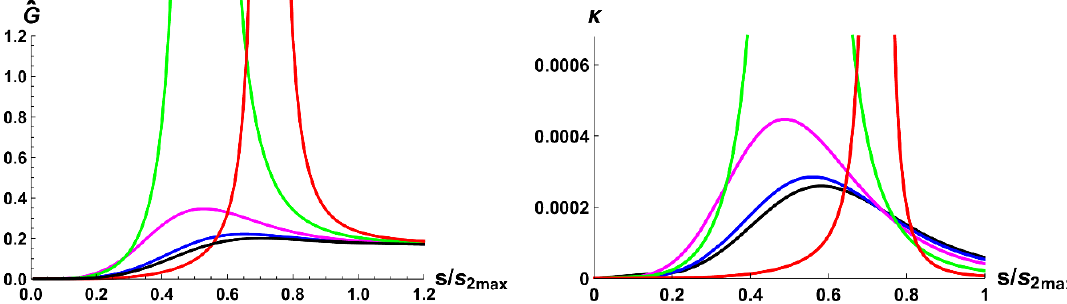
Figure 4 . Shear elastic modulus (left panel) and the shear viscosity (right panel) of the holo- graphic viscoelastic media to leading order in the explicit Z 2 symmetry breaking (see (4.11) for the parametrization). The color coding corresponds to di(cid:11)erent values of the ratio of temperature T to the chemical potential (cid:22) : T former two values are below the critical values of T=(cid:22) j crit at s = 0, and the latter two are above. Black curves correspond to neutral viscoelastic media, i.e., (cid:22) = 0.